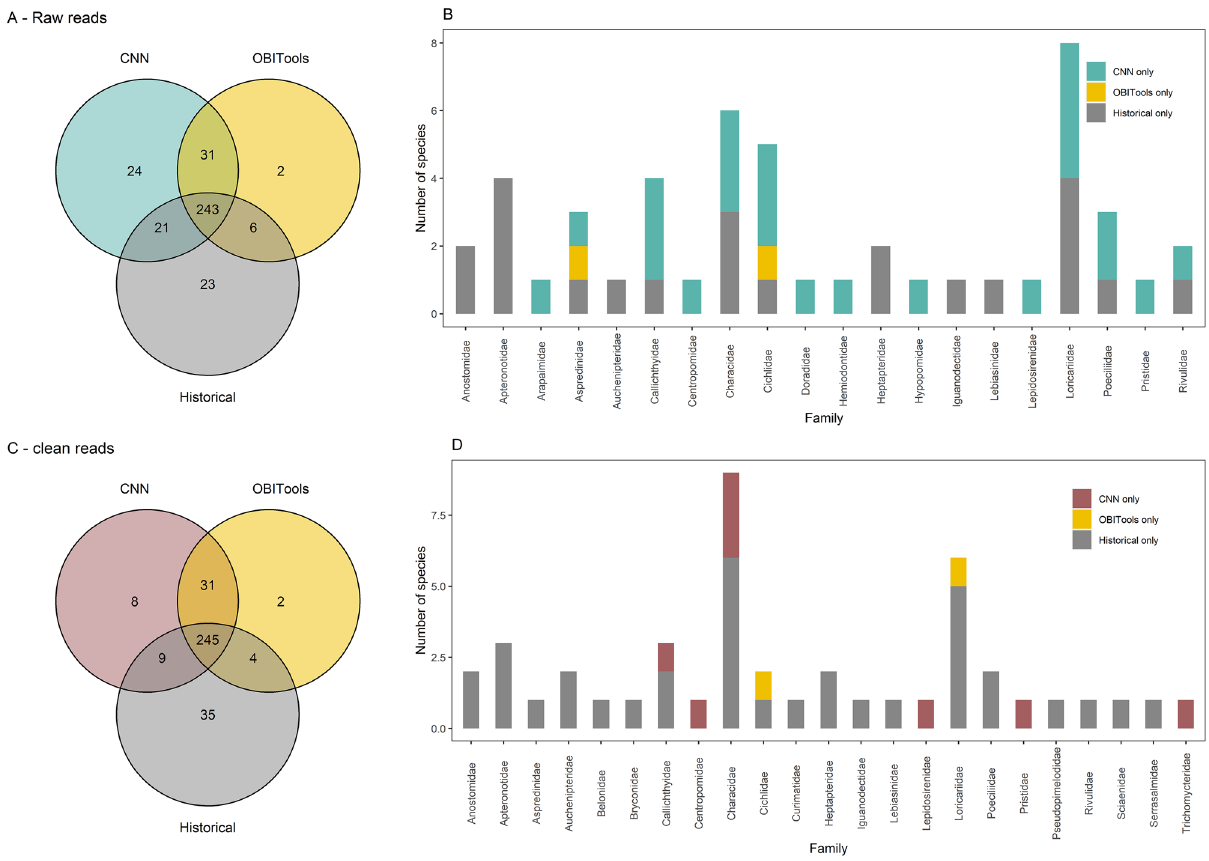
Figure 4. Species detections with the CNN approach, with OBITools, and in historical records in the combined Maroni and Oyapock rivers. ( A ) Overlap of species detections between the CNN applied to raw reads (blue), OBITools (yellow) and historical records (grey). ( B ) Number of species per family, detected with only one method (CNN applied to raw reads, OBITools or historical records). ( C ) Overlap of species detections between the CNN applied to clean reads (red), OBITools (yellow) and historical records (grey). ( D ) Number of species per family that were detected with only one method (CNN applied to clean reads, OBITools or historical